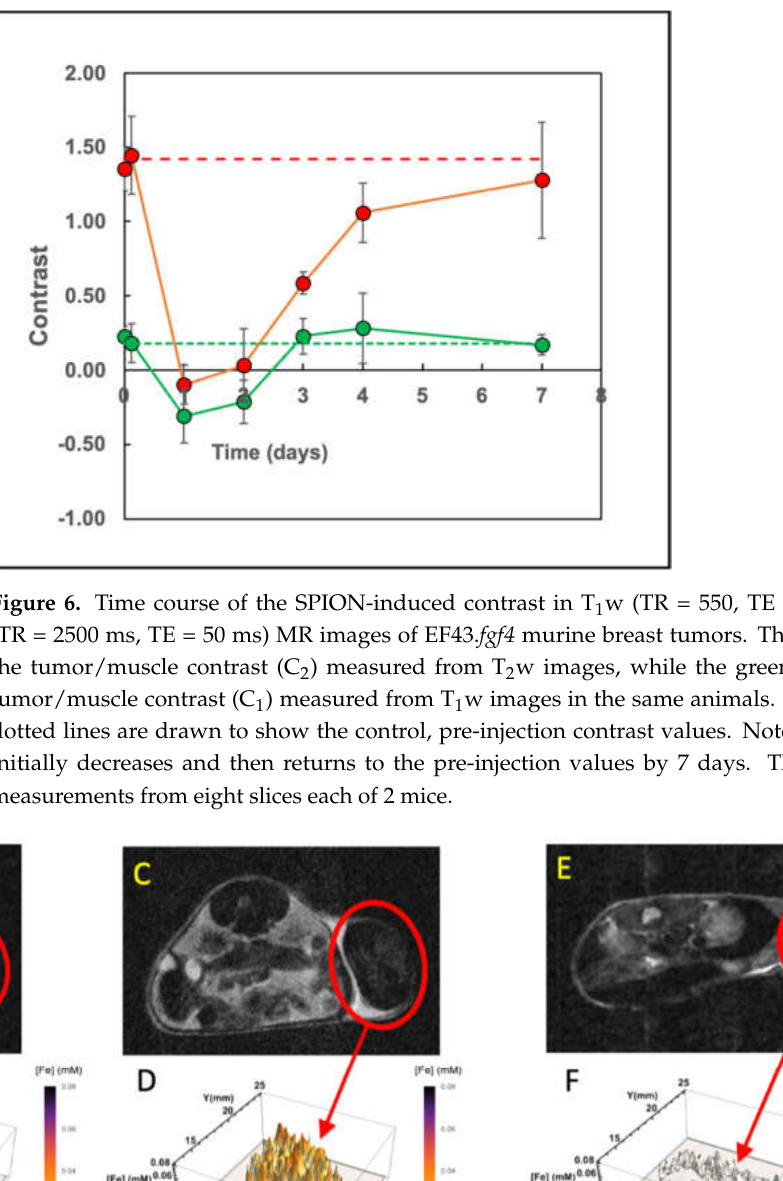
Figure 8. The dynamics of [Fe(t)] in the tumors after the injection of SPIONs as determined from the 3D [Fe(t)]MRI data. The red data points are measurements from eight slices each of 2 mice. Note that the uptake of iron is very small at 2.9 h (0.12 days). The black line is a fit to a gamma-variate function (see Section 2) with parameters A = 0.1165 mM, t 0 = 0.3453 days, and t h2 = 0.874 days. The mean transit time for the SPIONs was found to be 2.62 days. The maximum in the [Fe(t)] was found at 1.75 days (42 h).